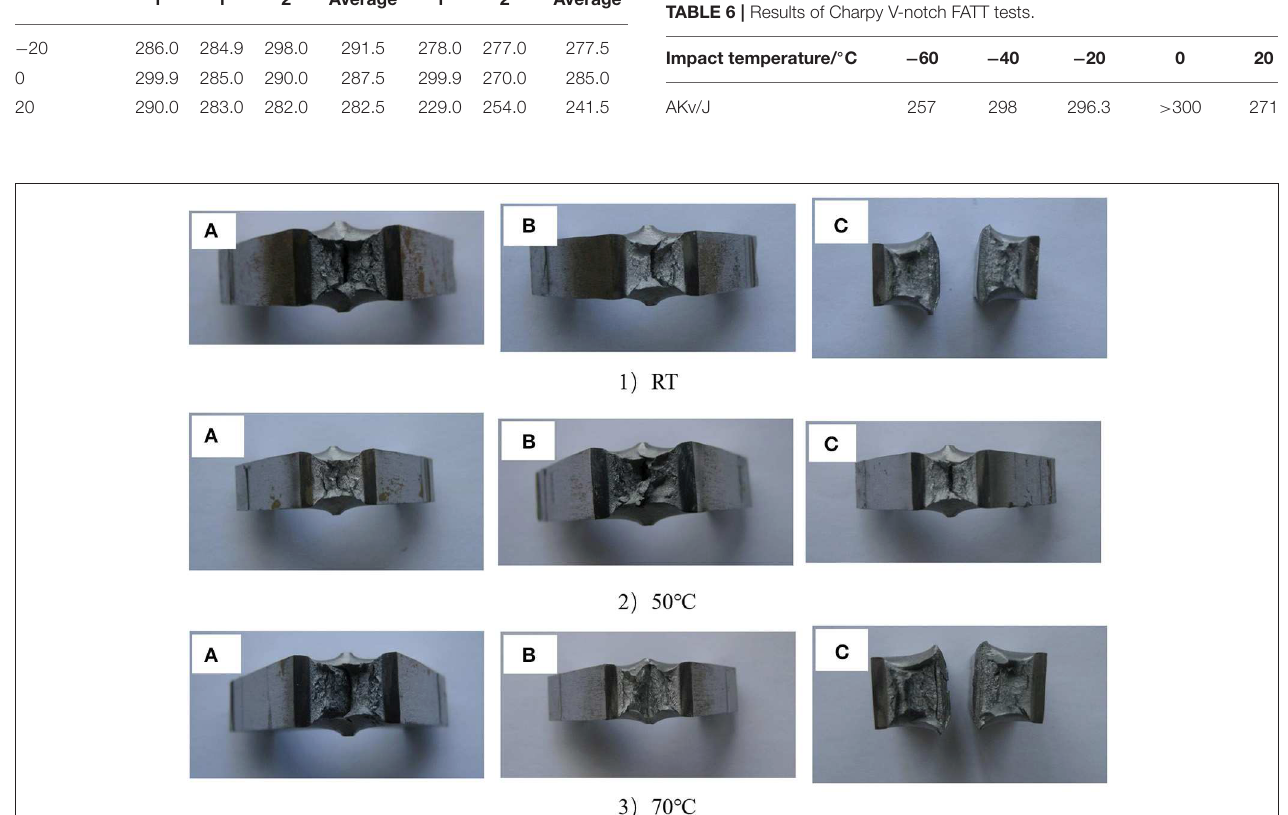
FIGURE 8 | Fracture morphology at various impact temperatures and preheating temperatures. (1) RT: (A) − 20 ◦ C, (B) 0 ◦ C, (C) 20 ◦ C. (2) 50 ◦ C: (A) − 20 ◦ C, (B) 0 ◦ C, (C) 20 ◦ C. (3) 70 ◦ C: (A) − 20 ◦ C, (B) 0 ◦ C, (C) 20 ◦ C.